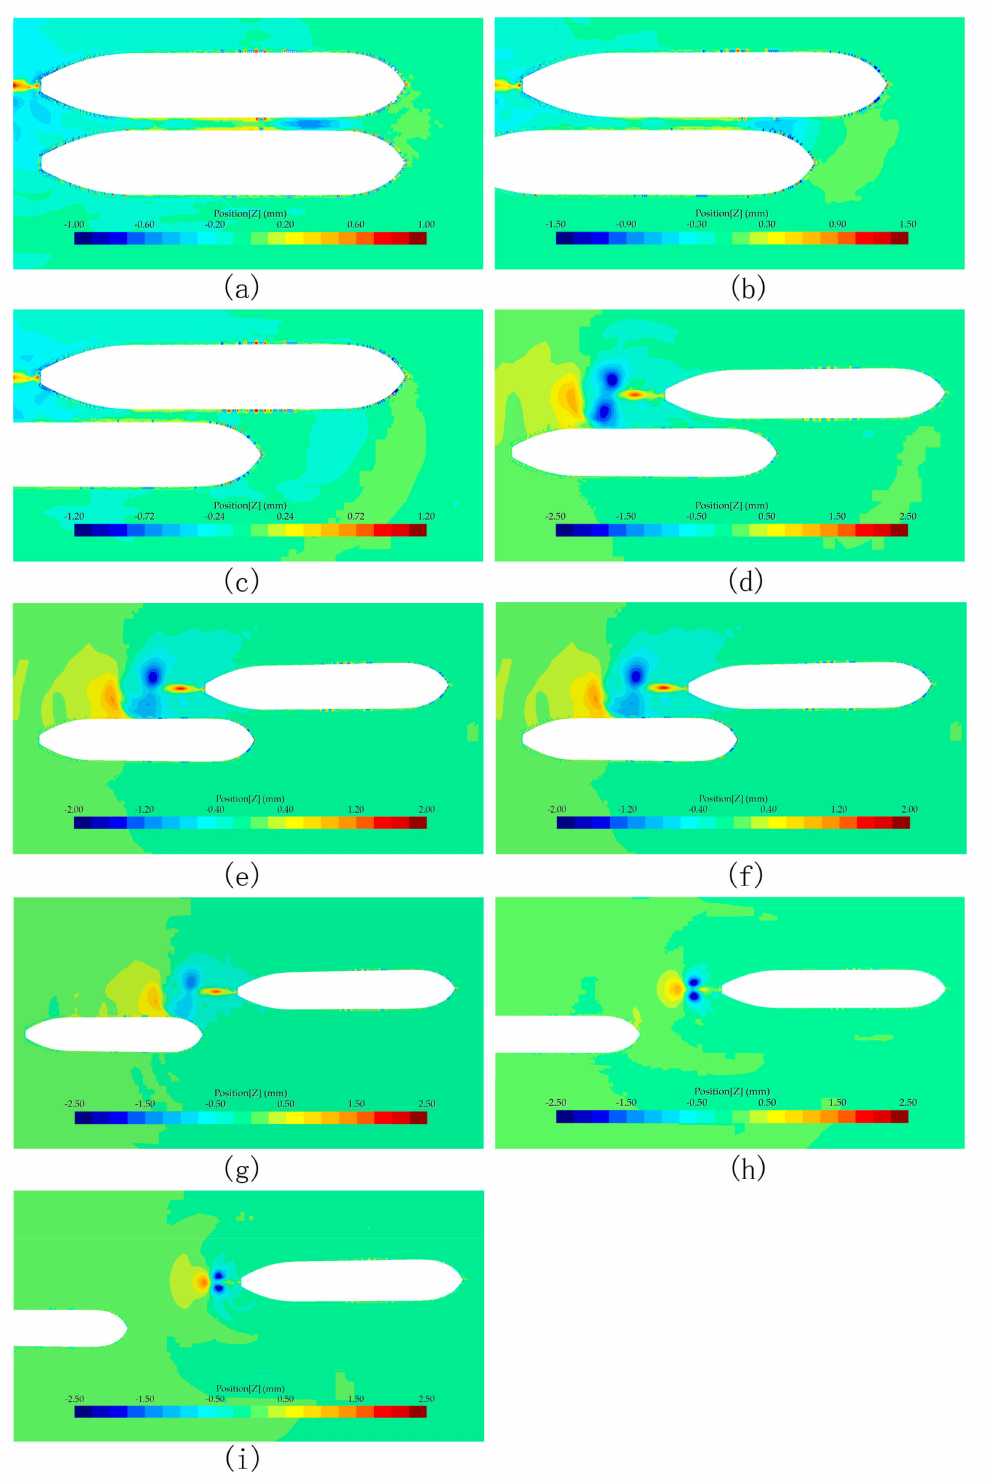
Figure 11. Surface elevation at different longitudinal positions of SOD and DS. ( a – i ) correspond to the 9 relative distances in the range of ξ (cid:48) = 0.0–3.2